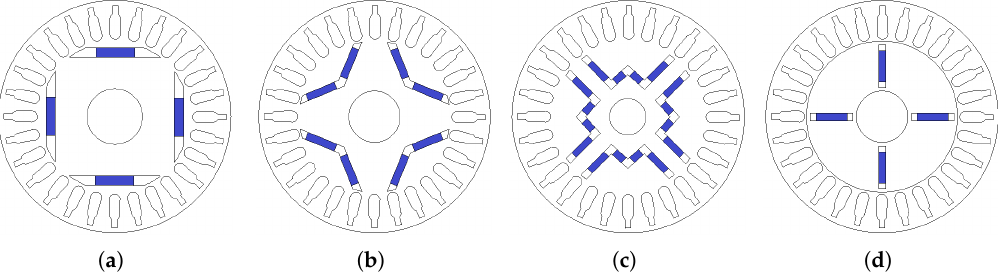
Figure 1. Various LSPMSM rotor layouts: ( a ) radial-type; ( b ) V-type; ( c ) W-type; ( d )